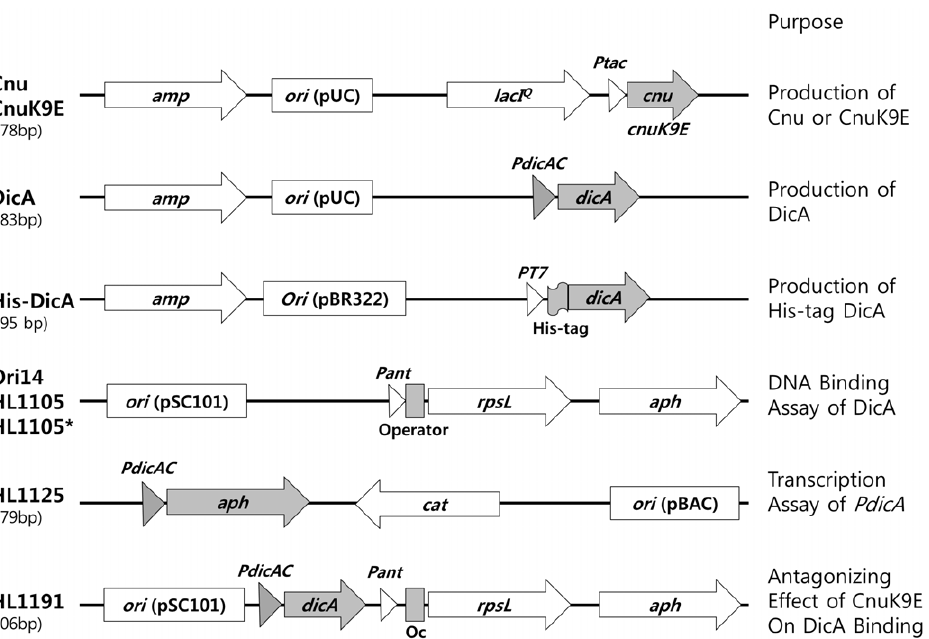
Figure 1. Plasmids used in this study. Plasmids are schematically presented along with their names, size in base pairs (bp), and purpose. Genes are depicted as arrows pointing in the direction of transcription. The origin of DNA replication ( ori ) is presented in a box with the conventional name of the plasmid. pOri14, pHL1105, and pHL1105* have the same sequence except the operator. The following sequences are present at the operator; 5 9 ATGATCGGTGATCCTG for pOri14, 5 9 TTGTTAGTCATAACTAACAA for pHL1105, and 5 9 TTGTTAGTCATAACTCACAA for pHL1105*. pOri14 has 7219 bp, and both pHL1105 and pHL1105* have 7216 bp each.